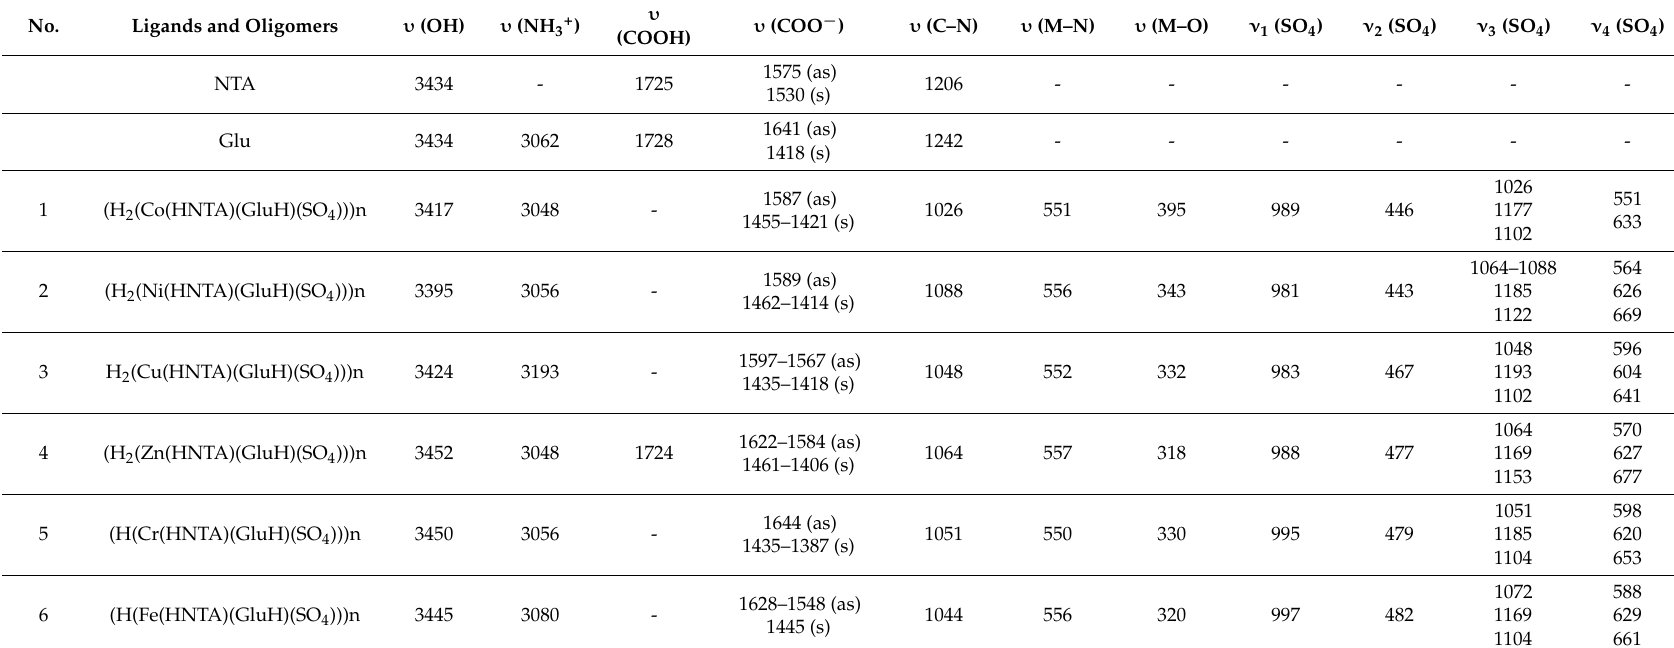
Table 2. The infrared data of the prepared coordination oligomers.